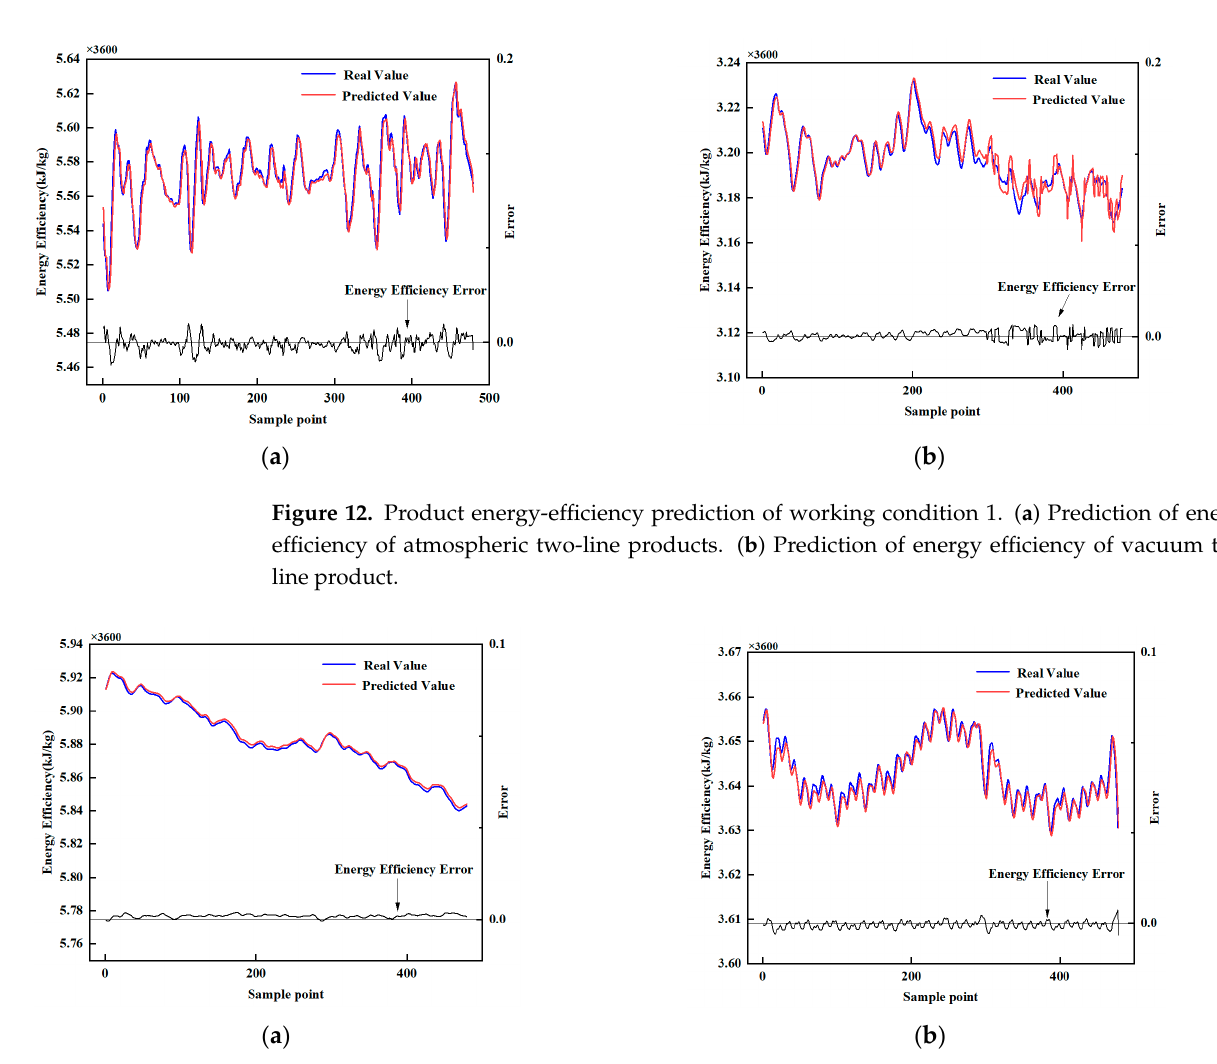
Figure 13. Product energy-efficiency prediction of working condition 2. ( a ) Prediction of energy efficiency of atmospheric two-line products. ( b ) Prediction of energy efficiency of vacuum two-line products.